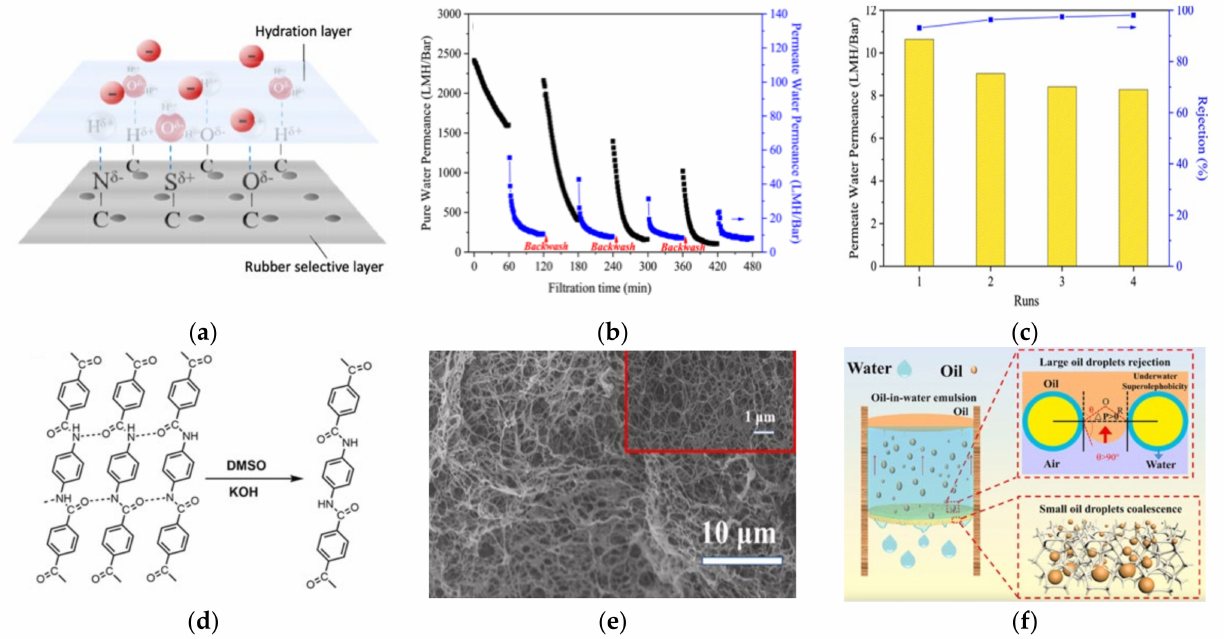
Figure 9. ( a ) Schematic illustration of hydration layer formation on rubber selective layer supported on ceramic substrate, ( b ) pure-water and permeate permeability of recycled rubber-derived NF membrane as a function of time, ( c ) permeate permeability of the membrane as a function of filtration cycles [163], ( d ) schematic illustration of the exfoliation of Kevlar fibre, ( e ) scanning electron microscope images of aramid nanofibre aerogel membrane, and ( f ) illustration of water-in-oil emulsion separation phenomena using aramid nanofibre aerogel membrane